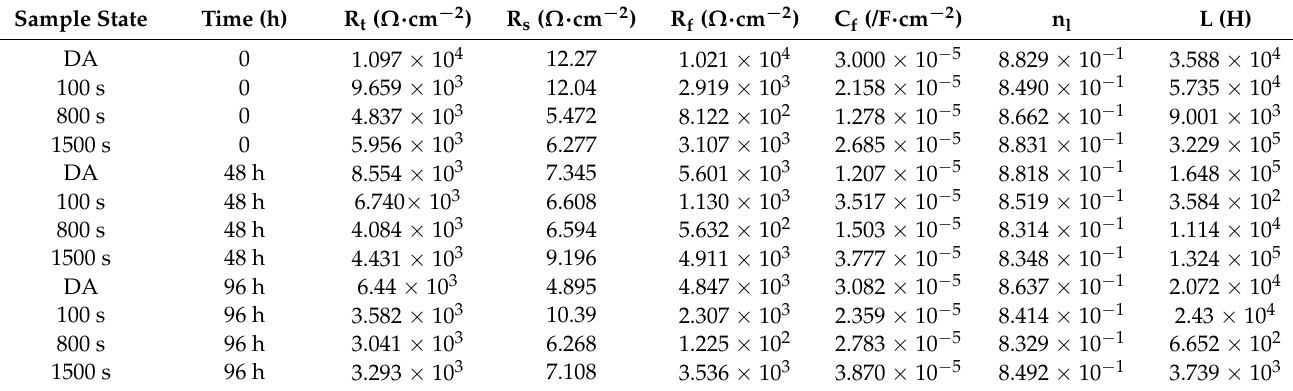
Table 4. Electrochemical parameters obtained from EIS